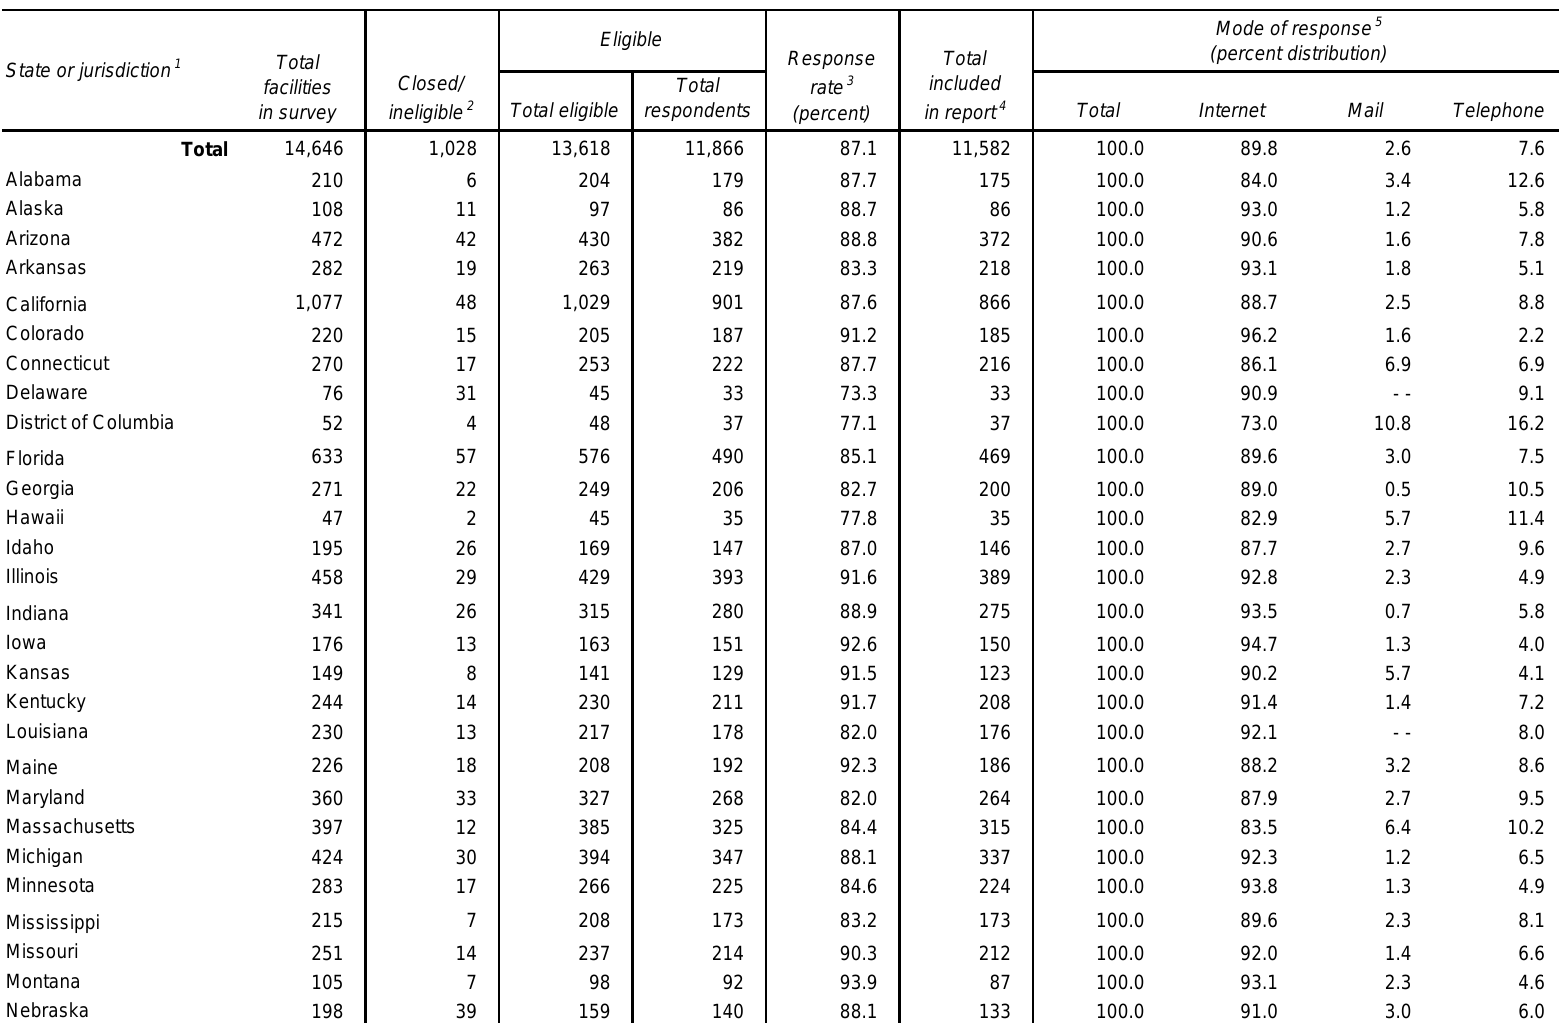
Table C2. N-MHSS facilities, by status, response rate, mode of response, and state or jurisdiction: